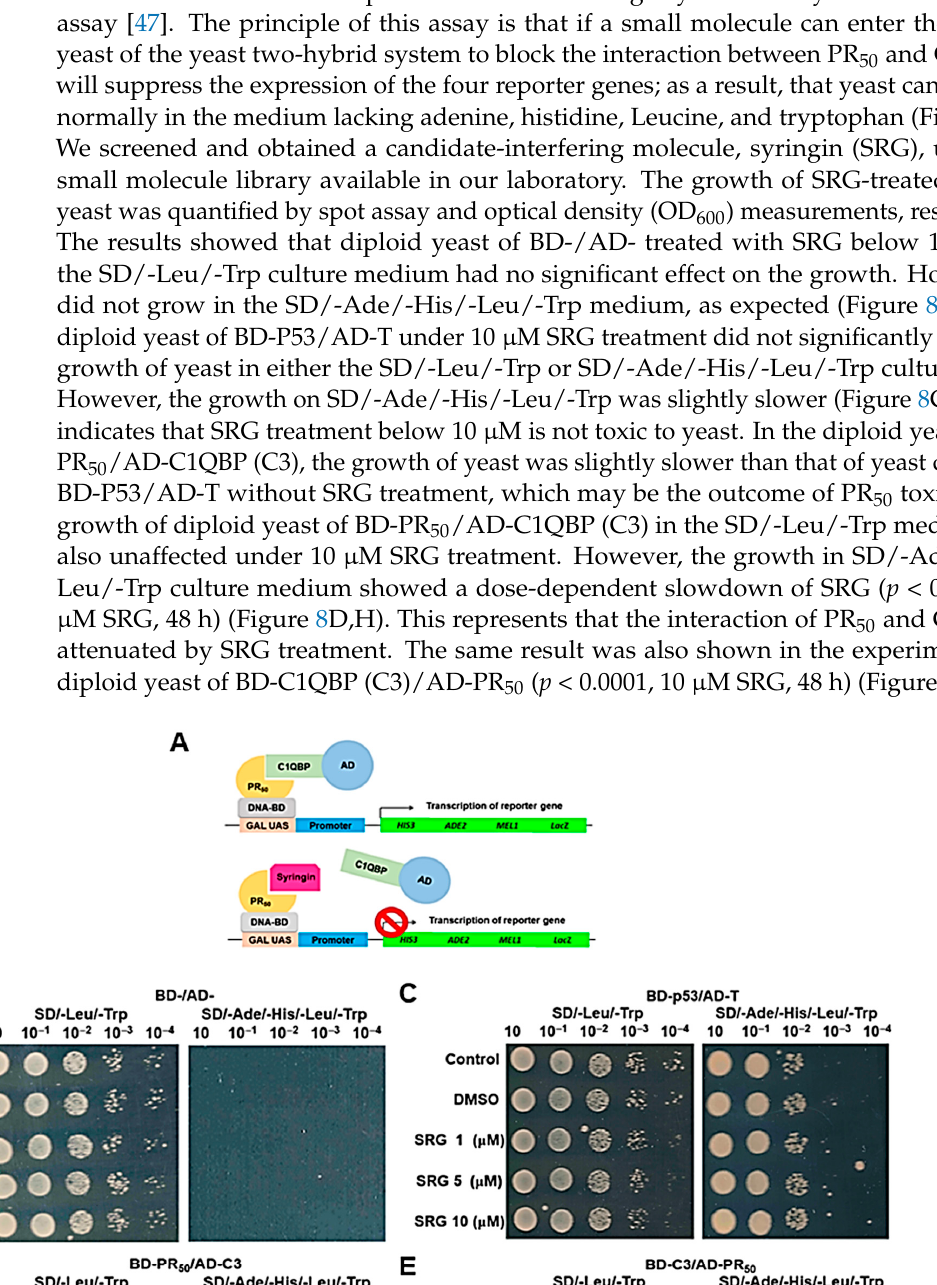
Figure 8. Syringin (SRG) blocked the interaction of PR 50 and C1QBP in the yeast two-hybrid-based growth assay. ( A ) Schematic drawing the principle of the yeast two-hybrid-based growth assay in